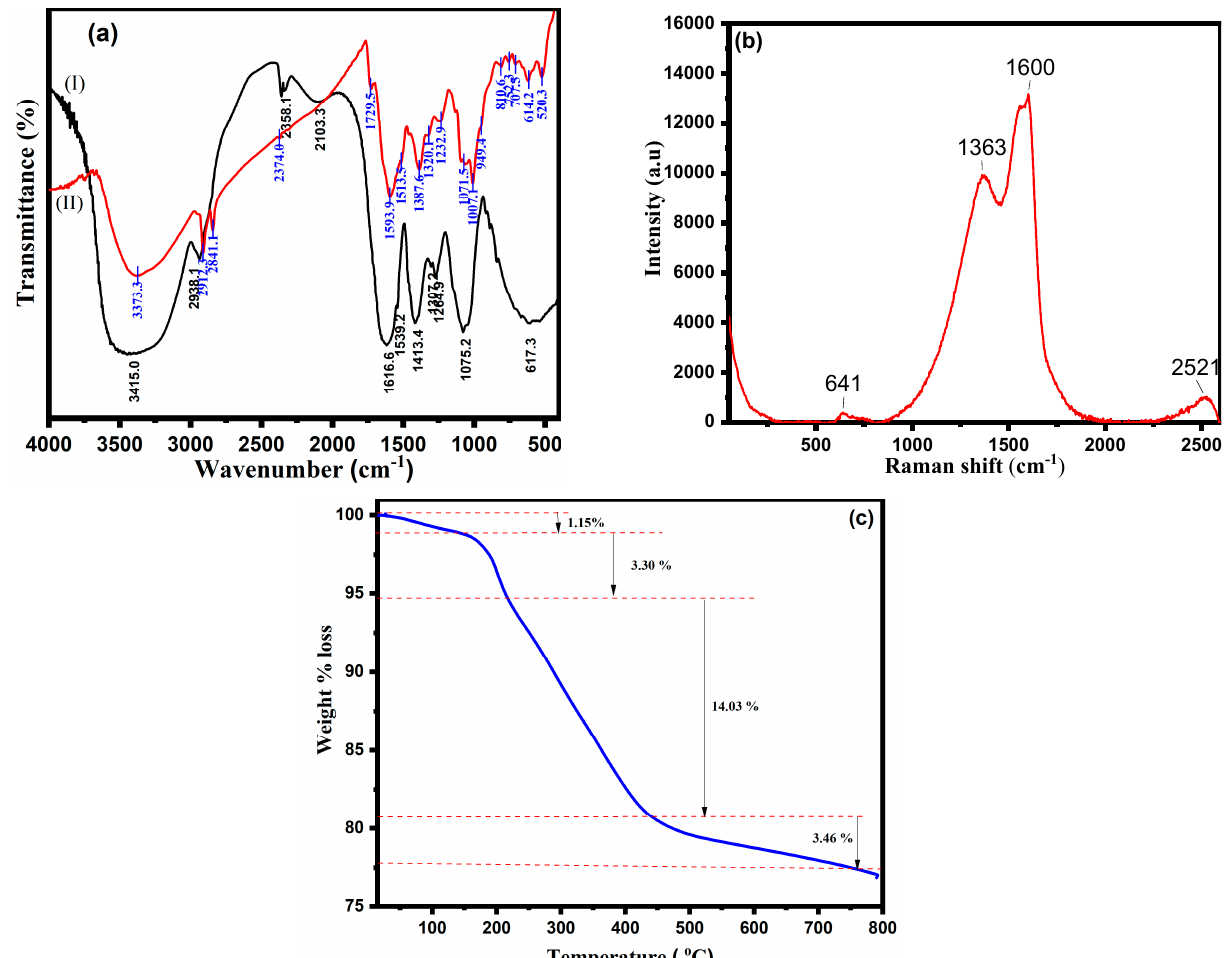
Figure 3. ( a ) FTIR spectra of (I) aqueous extract of CA (II) CA-AgNPs. ( b ) Raman spectra of CA-AgNPs. ( c ) TGA graph of CA-AgNPs.